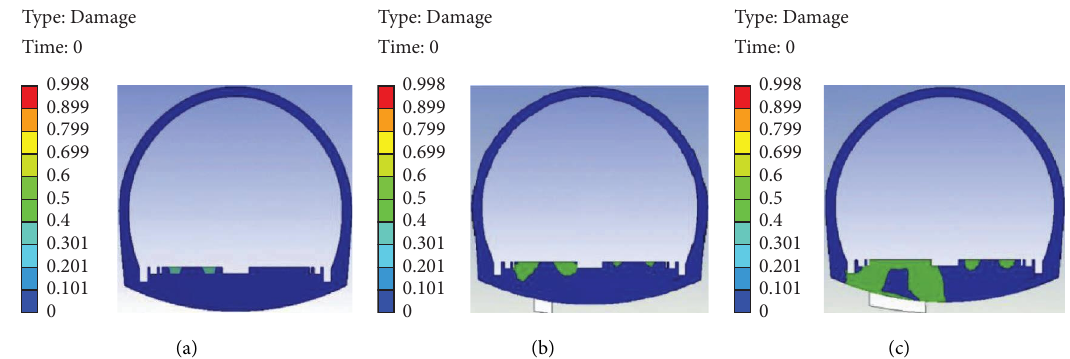
Figure 19: Distribution characteristics of substructure damage in three stages of surrounding rock in the ffth year of operation: (a) denser; (b) local cavity; (c) cavity connection.